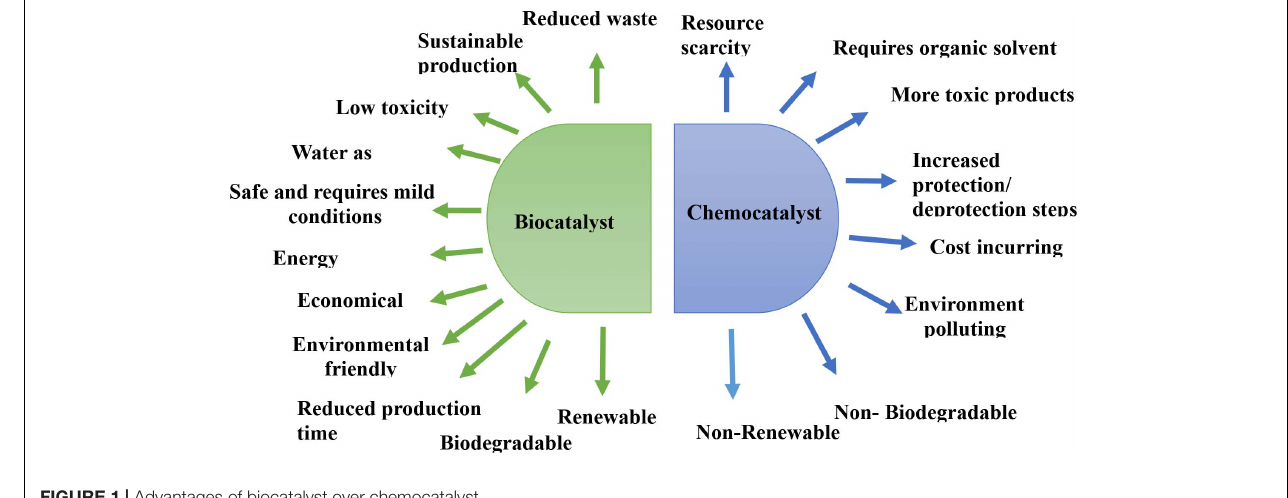
FIGURE 1 | Advantages of biocatalyst over chemocatalyst.